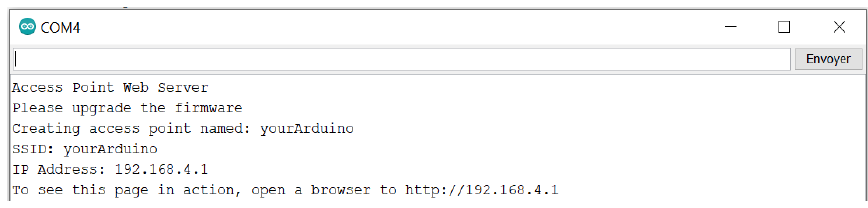
Figure 13. Arduino monitor showing the IP Address when creating the access point.